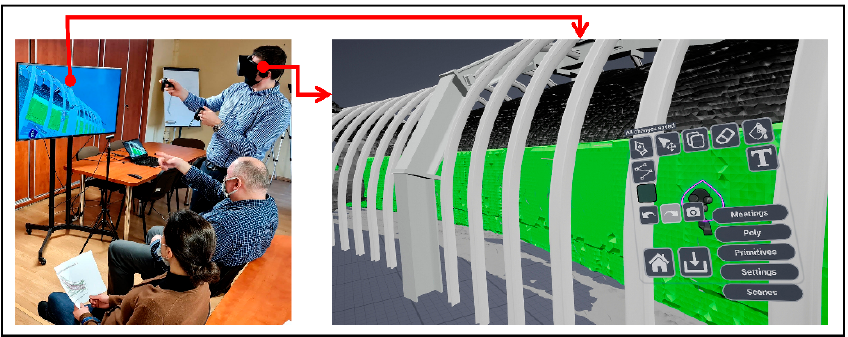
Figure 23. Evaluation of the redesigning results during a VR session [30].